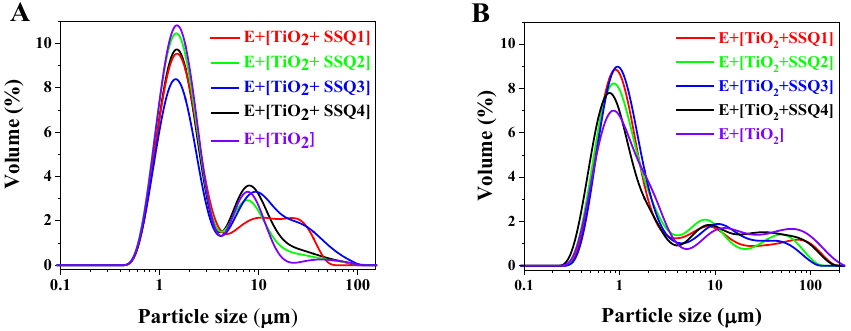
Figure 10. Particle size distribution of emulsions after preparation ( A ) and after 3 months ( B ).